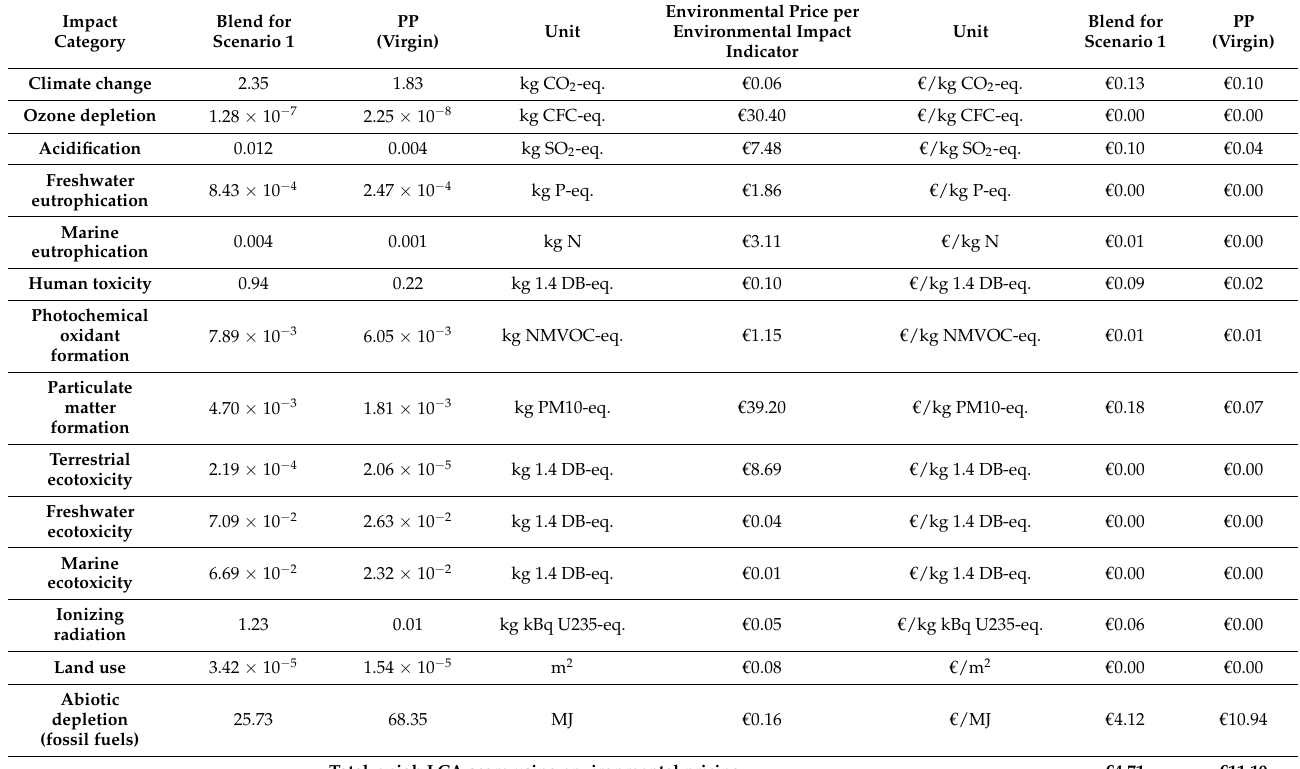
Table 7. Comparison between recycled blend (rPP/r-O-PET) and virgin PP for Scenario 1 on envi- ronmental pricing